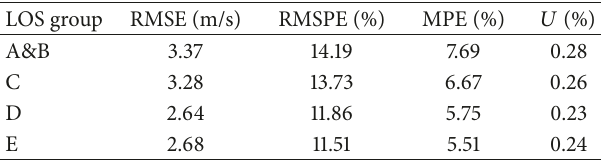
Table 4: Error tests of